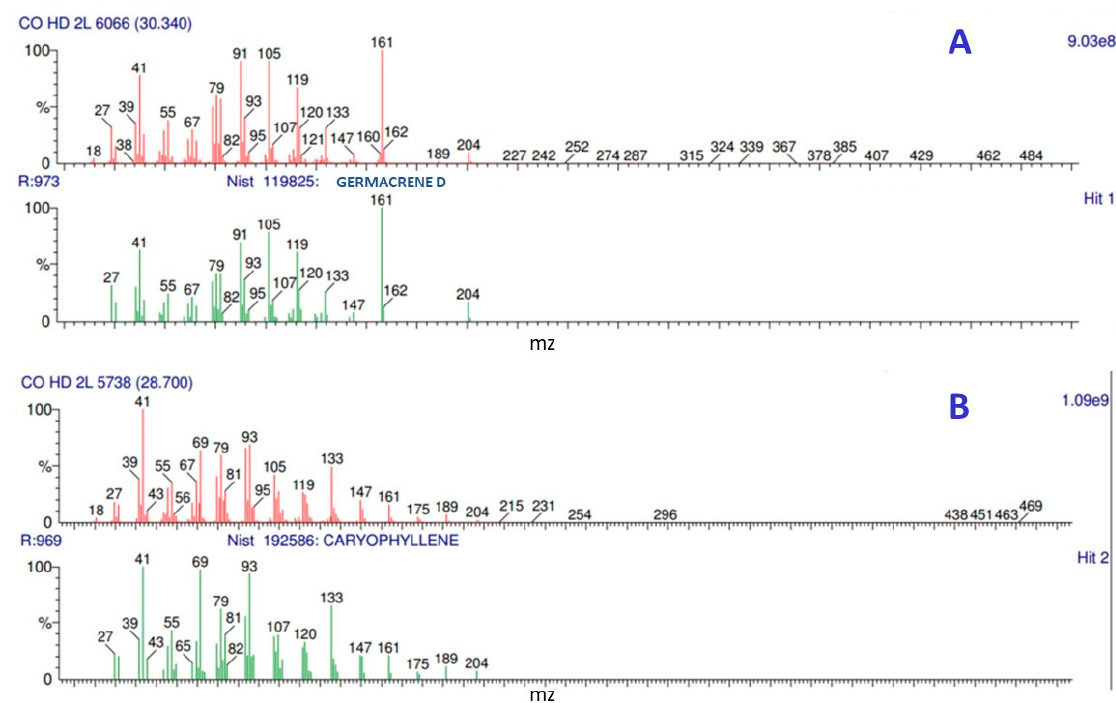
Figure 1. Mass spectrum of the major compounds identified in the Cedrela odorata essential oil. iden- tification with the mass spectrum of the NIST library. ( A ) Germacrene D, identification with an ap- proximation of 97.3%. ( B ) Caryophyllene, identification with an approximation of 96.7%.